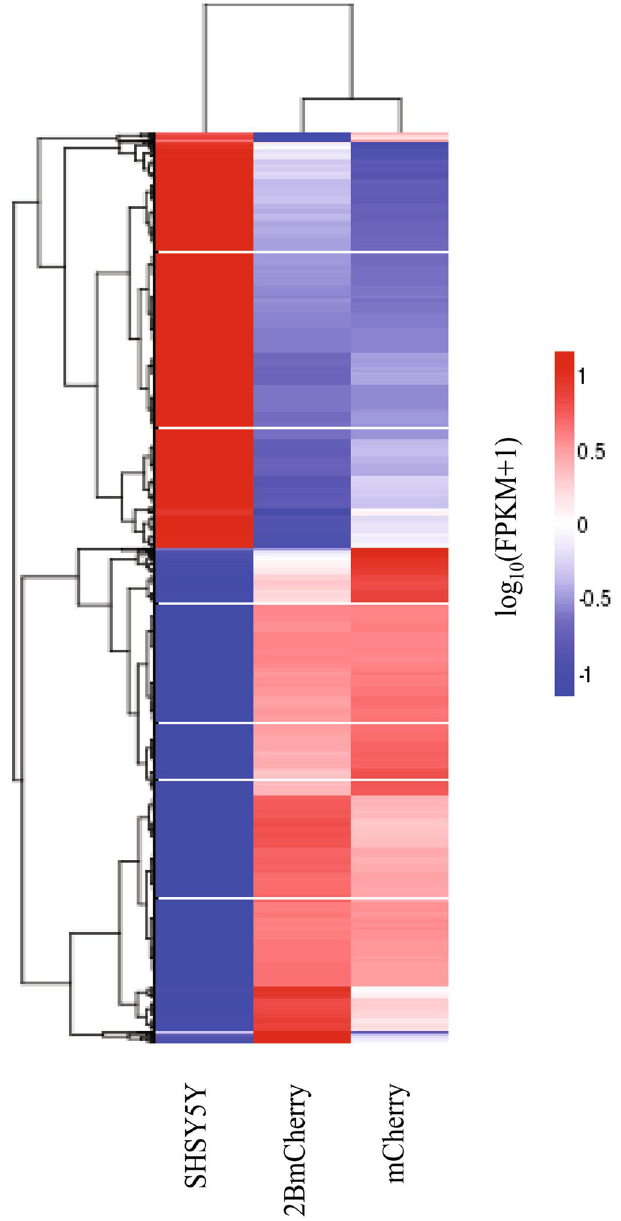
Figure 2. Unsupervised hierarchical heatmap clustering with double-dendrogram of the patterns of significant differences of DEGs among the three transcriptomes. DEGs are clustered in roll of each transcriptome displayed on the column. The gradient colors indicate the magnitude of changes in the gene expression levels, red color for upregulation and blue color for downregulation. Dendrogram on the top indicates a cluster of the genes with similar expression levels. Dendrogram on the left site indicates a similarity of the expression pattern across the